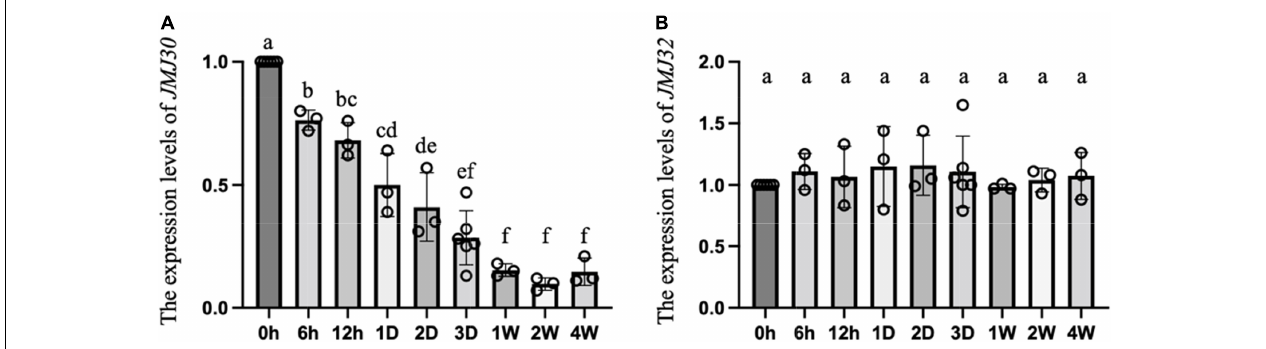
FIGURE 1 | The gradual reduction in the expression levels of JMJ30 during vernalization. The expression levels of endogenous JMJ30 (A) and JMJ32 (B) in seedlings at 3 days after germination. Seeds were treated with different lengths of cold (h, hour; D, day; W, week) in the dark after water absorption. Error bars represent SD. One-way ANOVA followed by the Tukey–Kramer test was performed ( p < 0.05). Different letters indicate significant differences, while the same letters indicate non-significant differences.